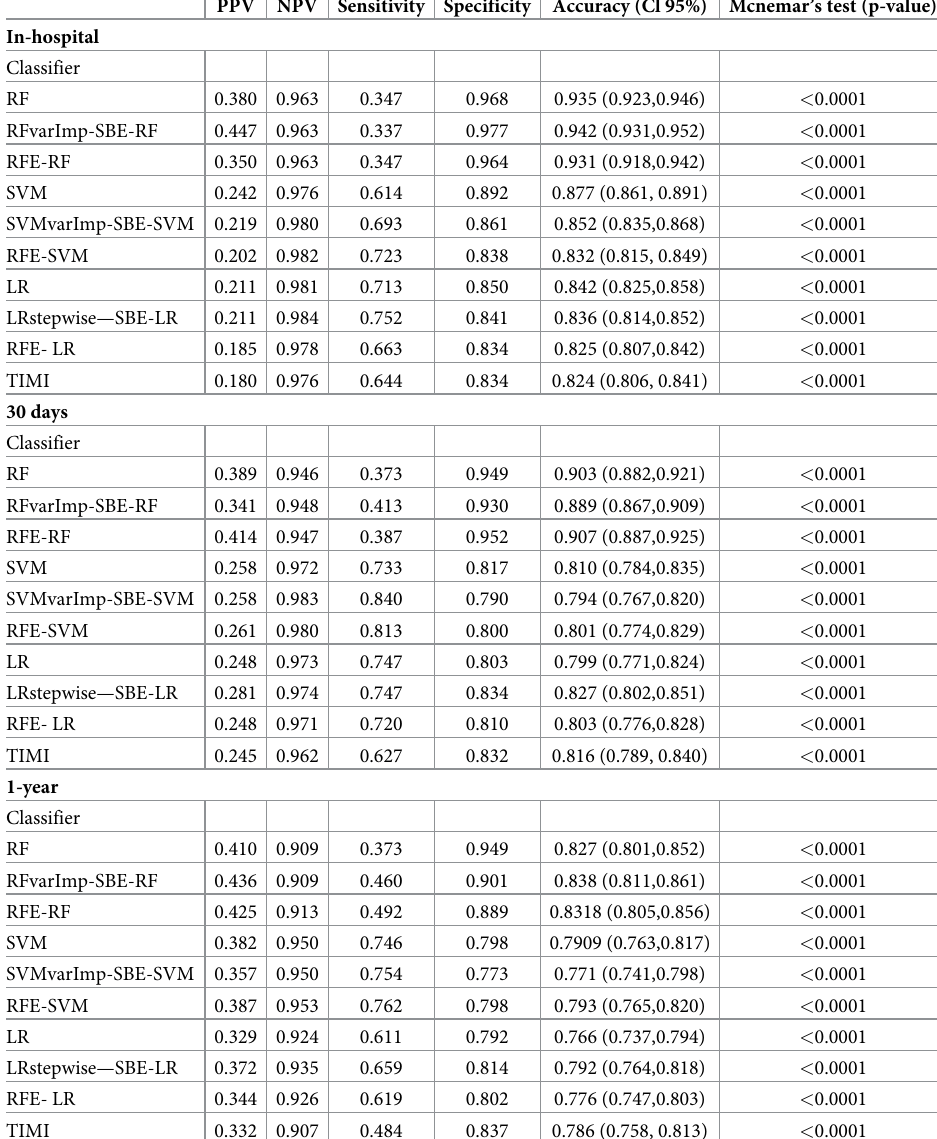
Table 3. Additional performance metrics based on a 30% validation dataset for TIMI risk score and ML models with and without feature